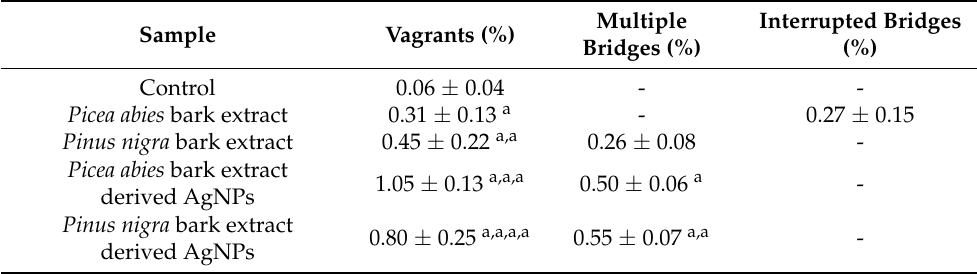
Table 3. Impact of Picea abies and Pinus nigra bark extracts and their derived AgNPs on chromosomal aberrations in Allium cepa root